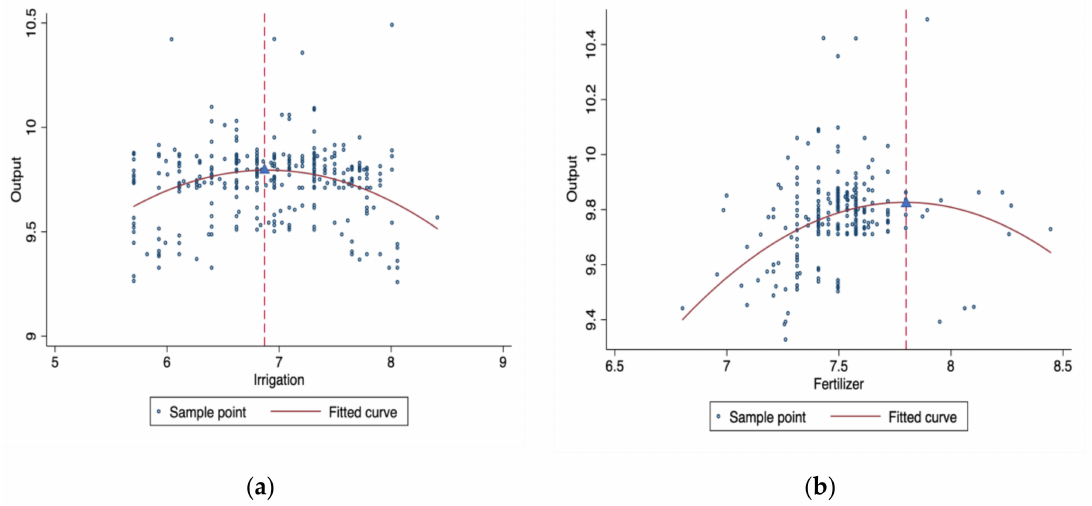
Figure A1. “U” relationship between the fertilizer, irrigation and the maize output. ( a ) “U” rela- tionship between the irrigation and maize output; ( b ) “U” relationship between the fertilizer and maize